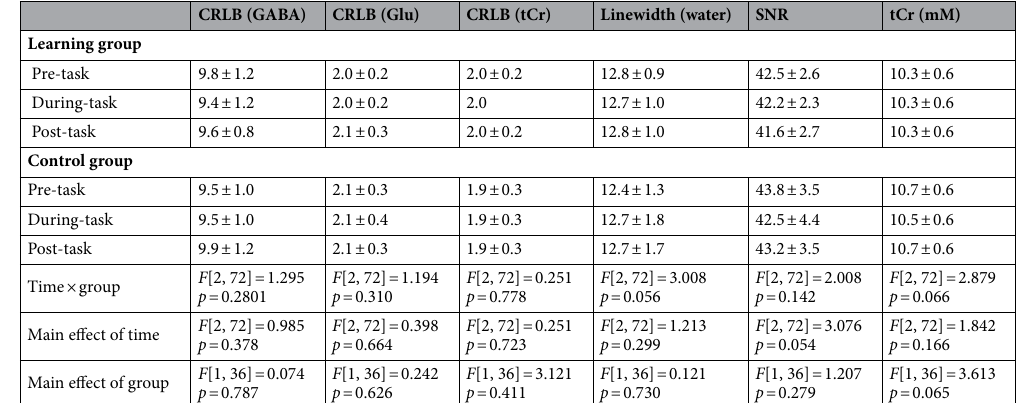
Table 1. Magnetic resonance spectroscopy spectra quality of pre-task, during-task, and post-task periods. Two-way repeated-measures ANOVA analysis was applied to the CRLB, water linewidth, and SNR separately, with the experimental group (learning vs. control) as a between-subjects factor while time points (pre-task, during-task, and post-task) as a within-subjects factor using SPSS. Data are presented as mean ± standard deviation (SD). CRLB Cramer–Rao lower bounds, Glu glutamate, tCr total creatine, SNR signal-to-noise